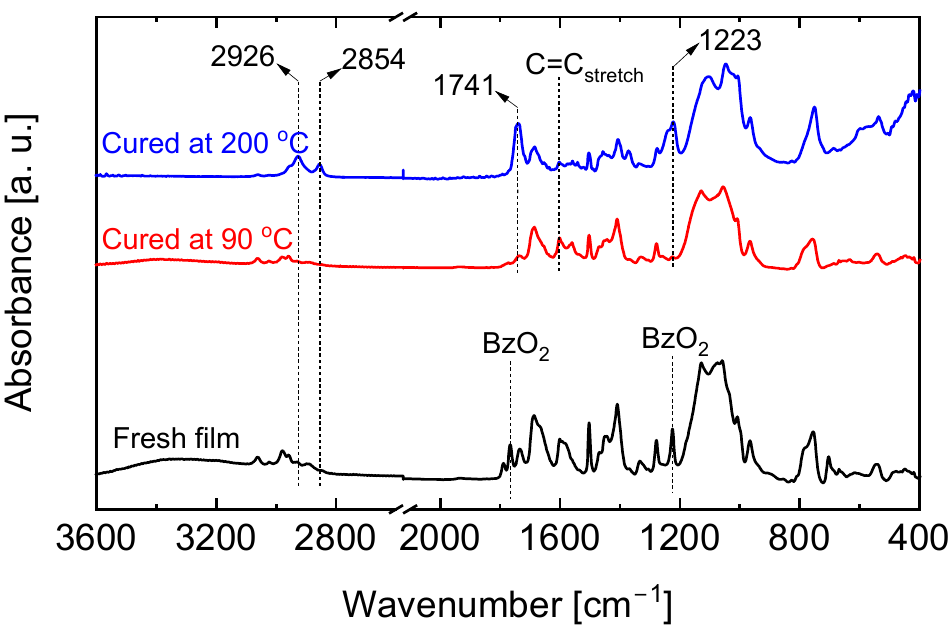
Figure 3. FTIR spectra of SiO 2 -ZrO 2 -polybenzoxzine before and after thermal curing at 90 (red line) and 200 °C (blue line).